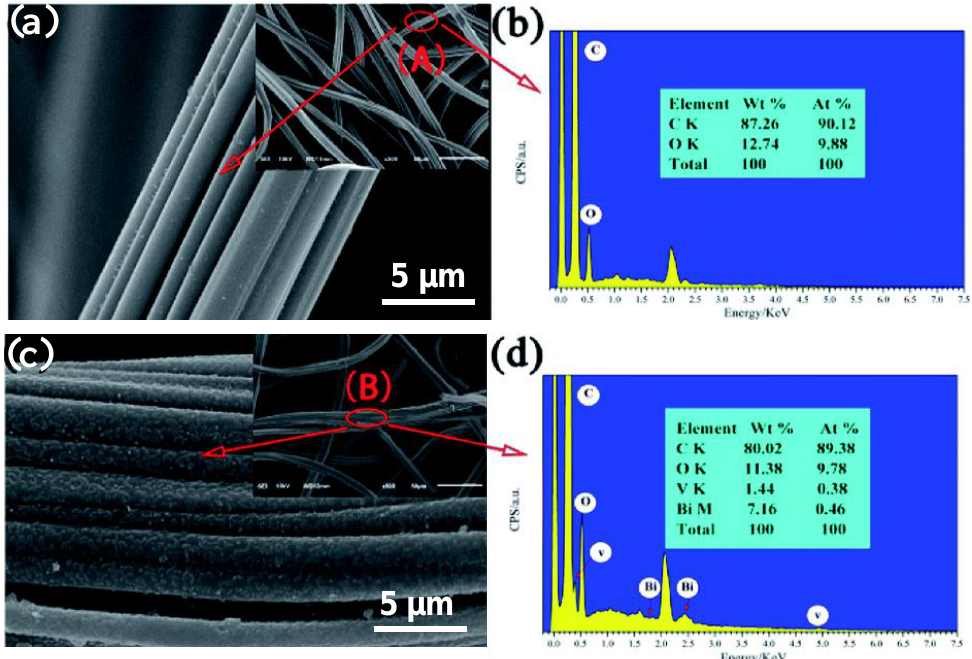
Figure 3. SEM images ( a , b ) and corresponding EDS spectra ( c , d ) original activated carbon fibers (ACFs) and BiVO 4 @ACFs. Adapted with permission from Reference [79]. Copyright (2018) Royal Society of Chemistry.